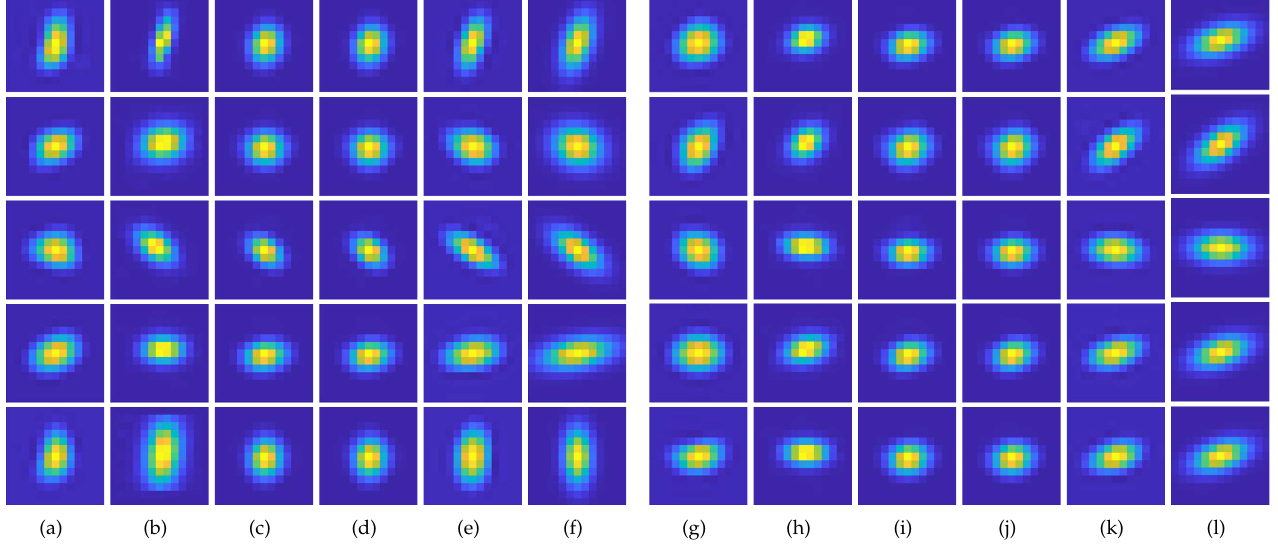
Figure 7. Qualitative results of the kernel estimation for scale factor of × 2 for DIV2KSK dataset. ( a , g ) KernelGAN [20], ( b , h ) FKP [21], ( c , i ) E-KernelGAN [22], ( d , j ) E-KernelGAN-DIP [22], ( e , k ) TVG- KernelGAN, ( f , l )